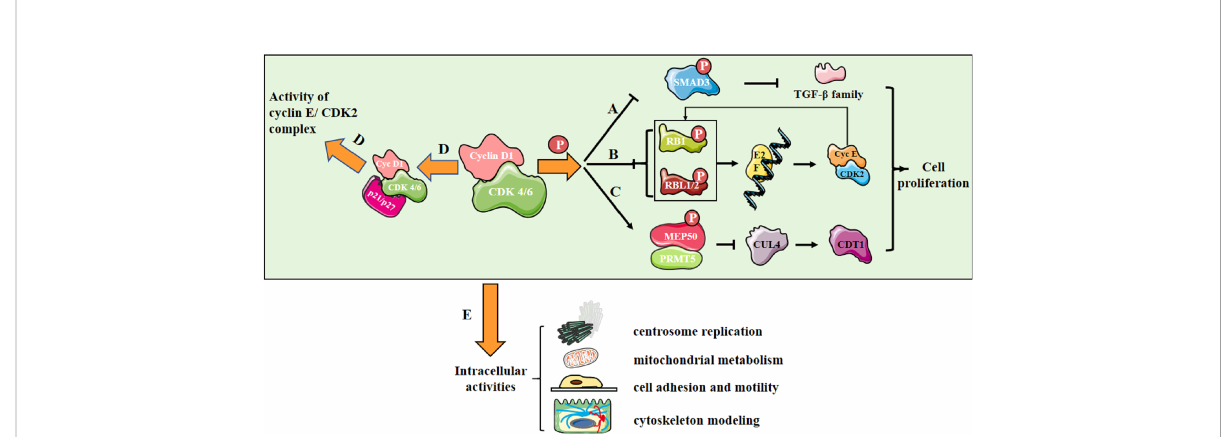
FIGURE 1 Cyclin D1/CDK4/6 promotes cell proliferation. (A) Cyclin D1/CDK 4/6 phosphorylates SMAD3 and downregulates the transcription of TGF- b family genes involving in growth inhibition; (B) Cyclin D1/CDK 4/6 phosphorylates RB1 and RBL1/2, leading to their inactivation and release of E2F family. E2F controls the transcription of genes essential for cyclin E synthesis, which will activate CDK2 and further promote RB phosphorylation, forming a positive feedback loop; (C) Cyclin D1/CDK4/6 triggers an increase in MEP50/PRMT5 activity and a decrease in the activity of CUL4, the E3 ligase of CDT1 and the replication licensing protein at the meantime; (D) Cyclin D1/CDK 4/6 sequesters the CDK inhibitors(CKIs) p21 CIP1 and p27 KIP1 , indirectly upregulating cyclin E/CDK2 activity; (E) Molecular activities mediate intracellular activities, including centrosome replication, mitochondrial metabolism, cell adhesion and motility, and cytoskeleton